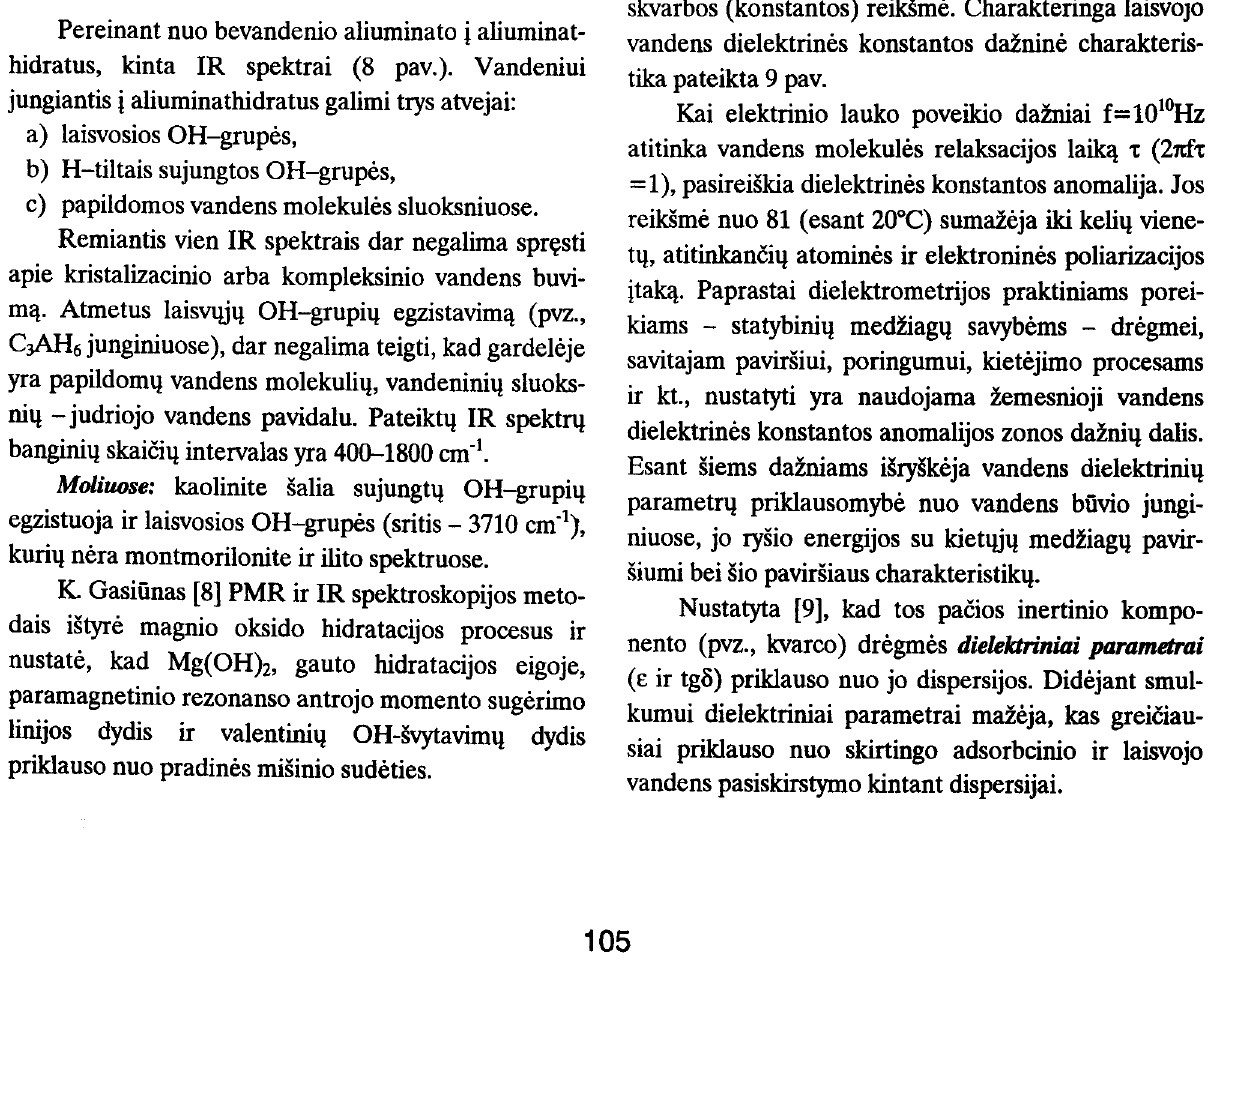
4.7. Vandens savybiq dielektrometrija Kaip buvo mineta, del asimetriniq kriiviq